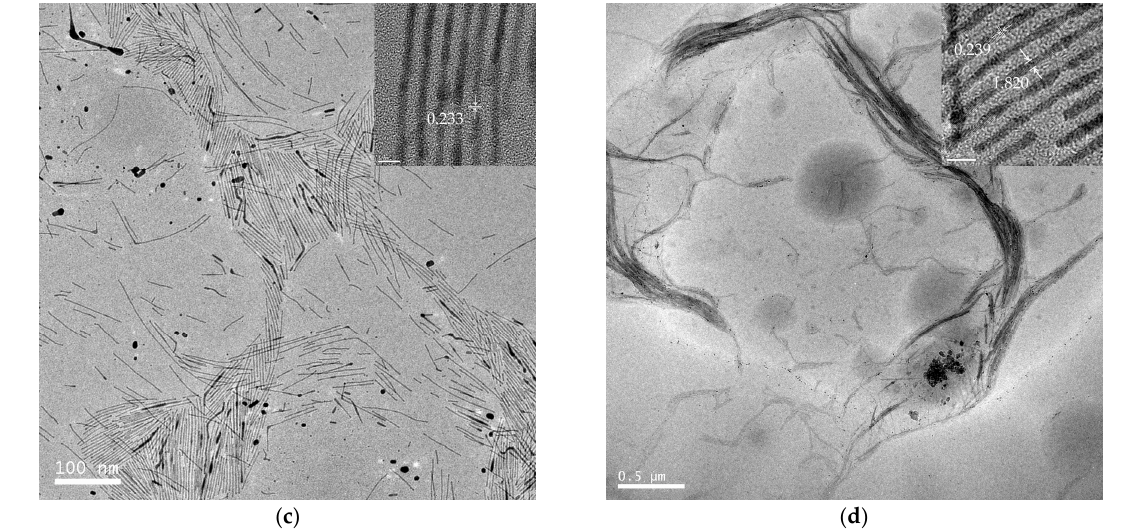
Figure 1. Transmission electron microscope (TEM) and high resolution transmission electron microscope (HRTEM) images of gold round nanodots ( a ); short nanobars ( b ); long nanorods ( c ); and silk-like ultralong and ultrathin nanowires ( d ) prepared at [TPS]:[Au]:[OA]:[OAm] = 3:1:0.8:3.8, 3:1:48:45.6, 3:1:24:45.6, and 3:1:24:114, respectively.